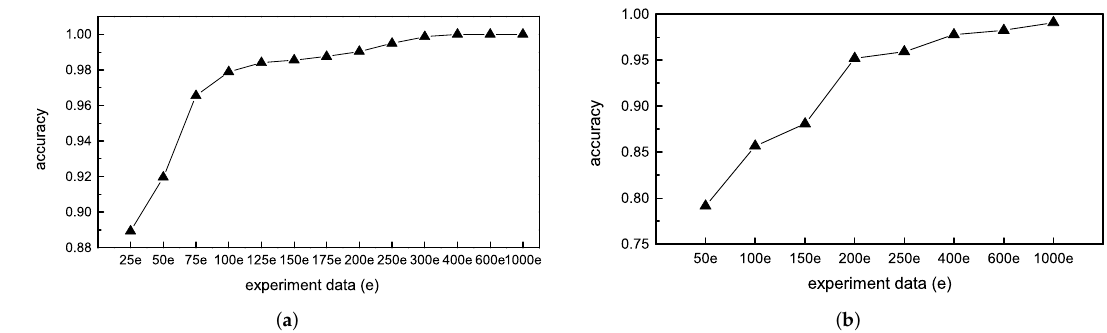
Figure 9. Fault classification under case A. ( a ) 0.021 inches, ( b ) 0.014 inches.